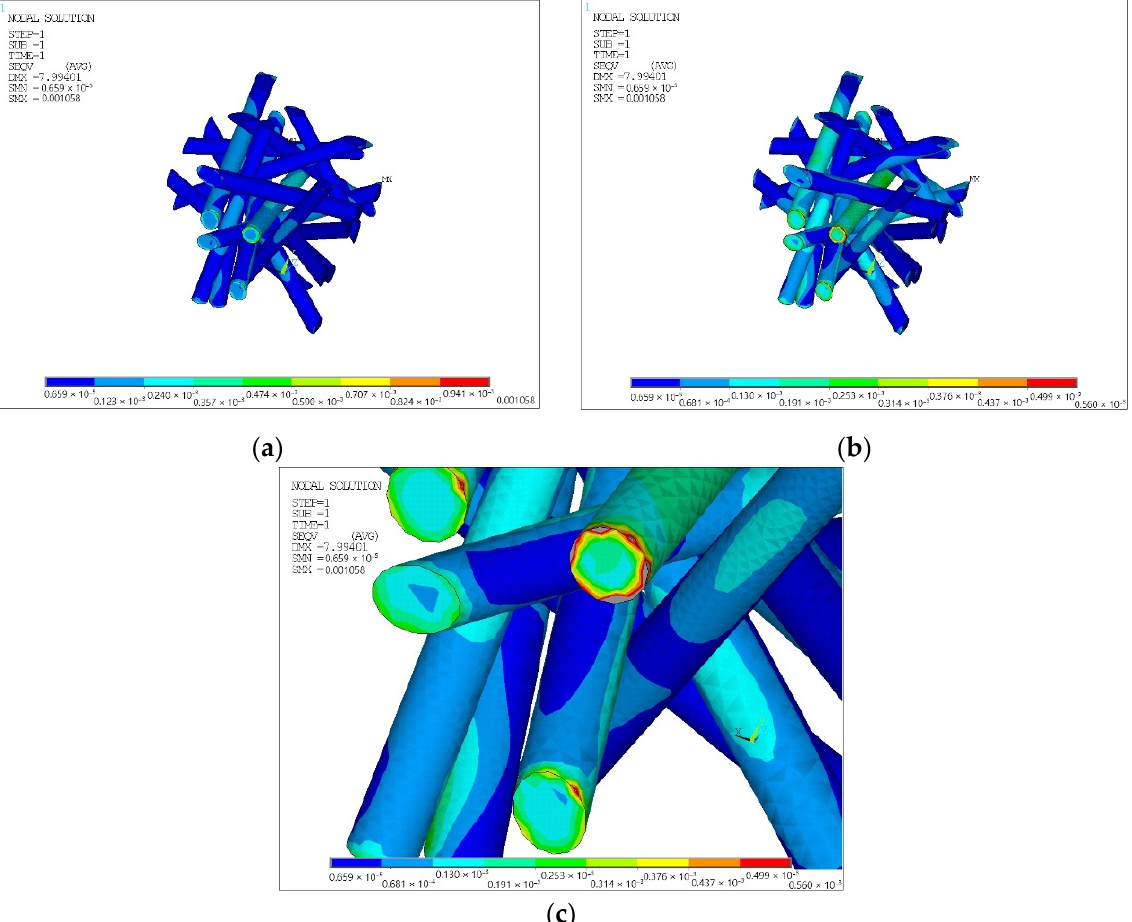
Figure 7 . Equivalent von Mises stress for cylindrical filler, (10 − 6 MPa): ( a ) without restrictions on the magnitude of stresses; ( b ) with stress values up to the strength limit of the cylindrical filler 560 MPa; ( c ) with stress values up to the tensile strength of the cylindrical filler 560 MPa in the area of excess (the view from the opposite side is similar and not shown).